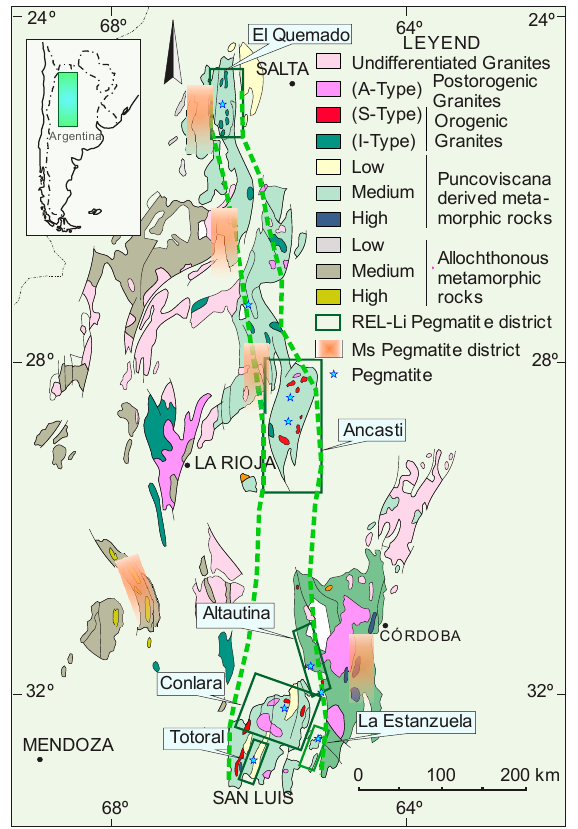
Figure 1. Geological map of the Pampean Pegmatite Province showing the rare-element pegmatite belt and the main districts (modified from [40]). The insets show the location of the Li-bearing pegmatite districts.